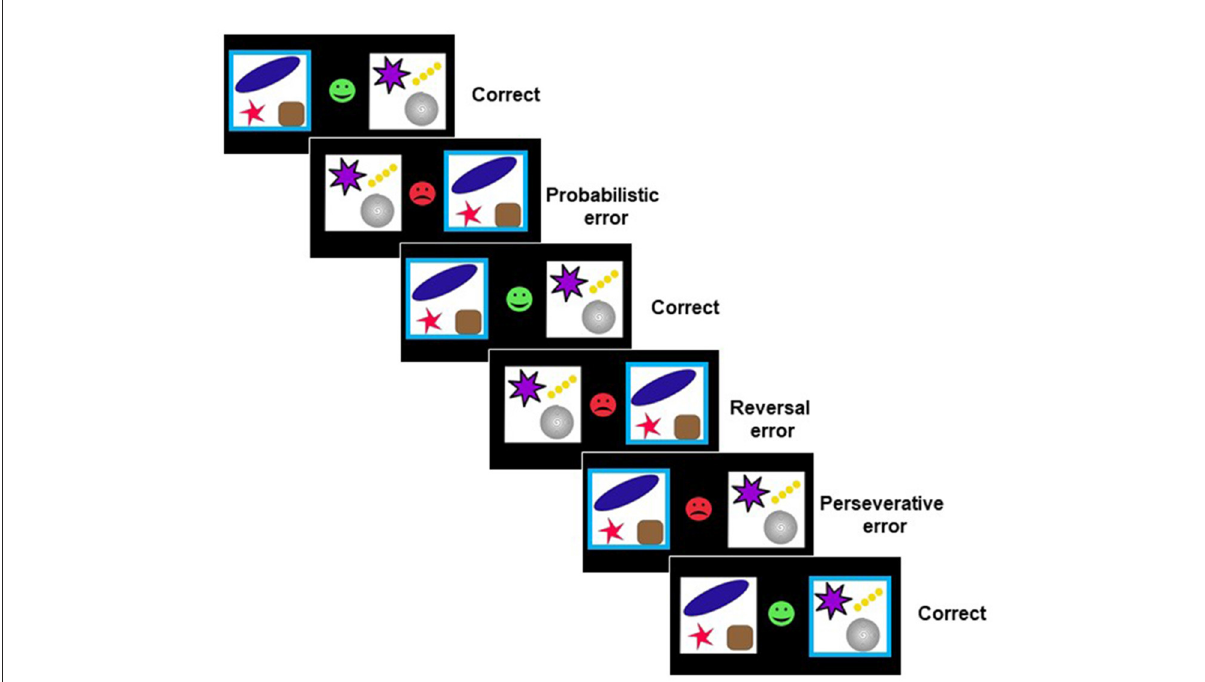
FIGURE1 Probabilistic reversal learning task (2). On each trial, subjects were confronted with two abstract symbols. Feedback (a green smiley face or red sad face) was presented after choosing one of the symbols by a left or right button press. Using trial-and-error feedback, subjects must discover which of the two patterns is